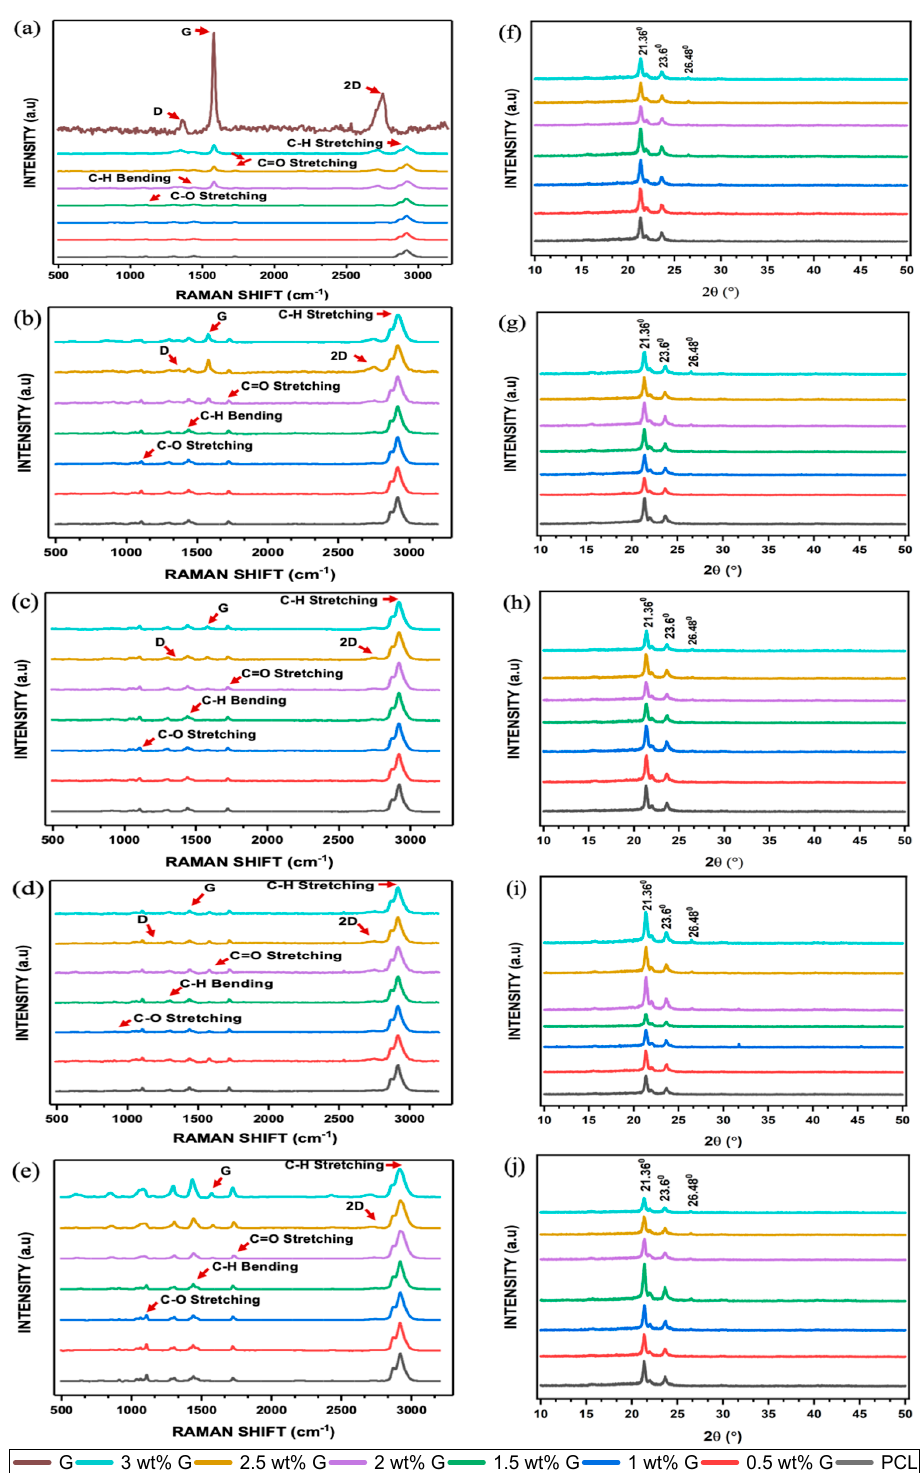
Figure 5. Raman spectroscopy of PCL/G scaffold. ( a ) Initial; biodegradation process: ( b ) 1 month; ( c ) 2 months; ( d ) 3 months; ( e ) 4 months. X-ray diffraction of PCL/G scaffold. ( f ) Initial; biodegrada- tion process: ( g ) 1 month; ( h ) 2 months; ( i ) 3 months; ( j ) 4